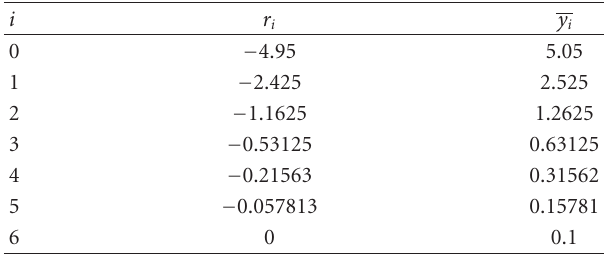
Table 1: Pseudoreferences and associated output